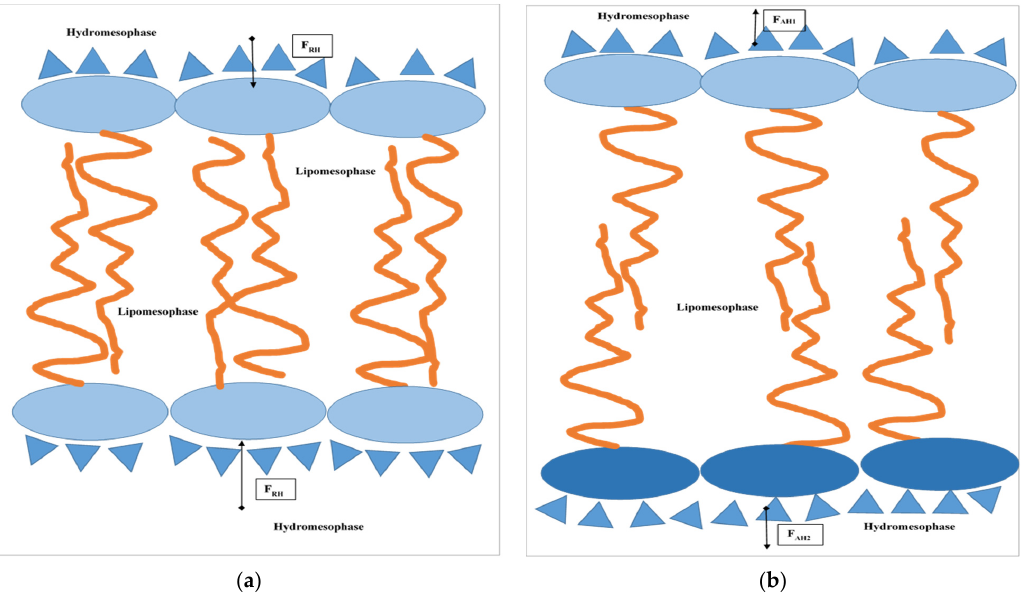
Figure 2. Stylized illustration showing a hydrotropic bilayer formed by amphiphilic molecules in water medium with prevailing hydration repulsive/attractive forces. ( a ) Prevailing hydro-repulsion; ( b ) Prevailing hydro-attraction. Dark and pale blue shades represent the hydrophilic groups of amphiphilic molecules with prevailing proton donor and proton acceptor activities towards water molecules, respectively. The symbols “ ∆ ” denominate water molecule O < HH .